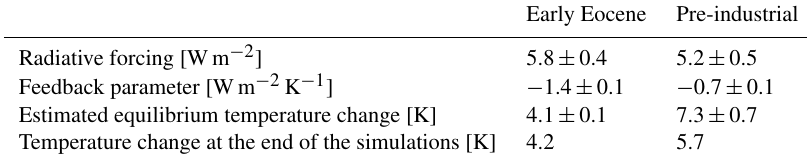
Table 3. Net radiative forcing by afforesting a bright desert world for the early Eocene climate and the pre-industrial climate. Further, the net feedback parameter and the equilibrium temperature change are listed. The values are derived from the comparison of the respective forest world with the respective bright desert world using the linear regression approach (Sect. 3.1). The estimated equilibrium temperature change is based on Eq. (6). The 95% confidence interval is given. The transient temperature change refers to the temperature difference averaged over the last 30 years of the simulations.